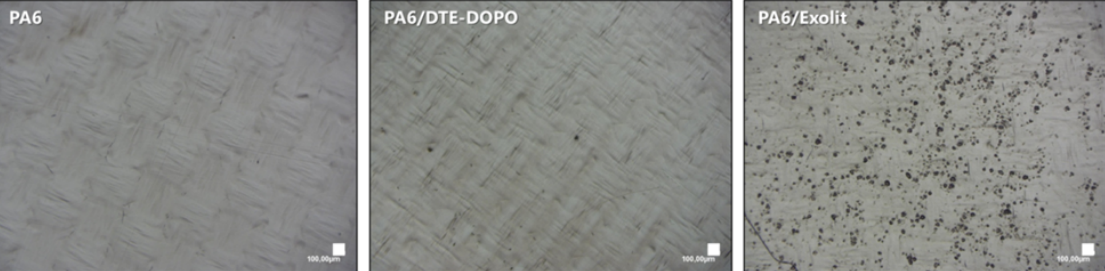
Figure 4. SEM images of the fracture of neat PA6 and PA6/ FRs formulations after their treatment in liquid N 2 . Upper row shows the images of the materials located in between the walls of the metallic holder. Lower row presents higher magnification images.